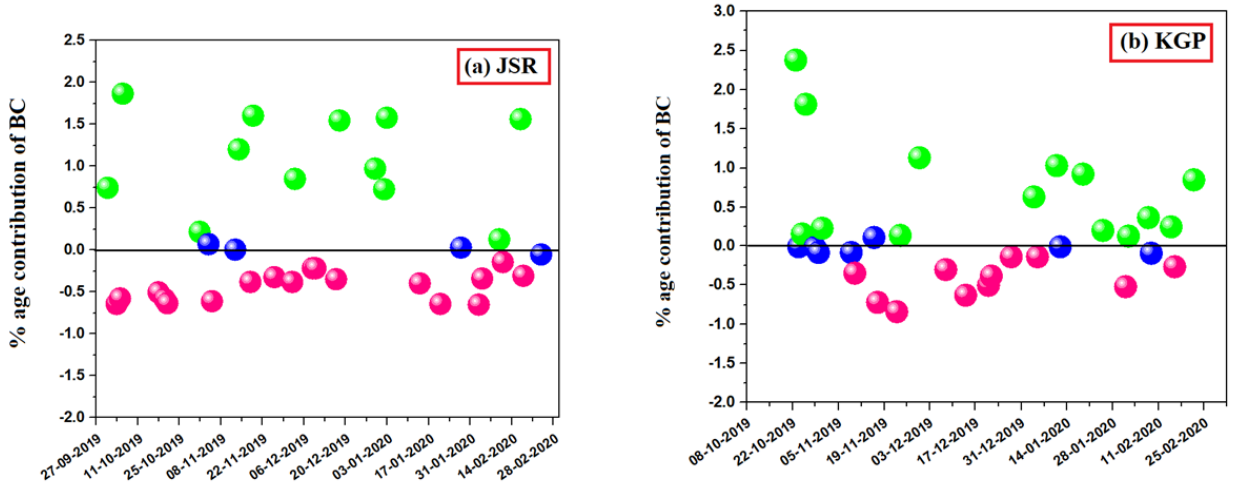
Figure 5. Fractional contribution of BC measured at 370 and 880 nm at ( a ) JSR and ( b ) KGP sites. (Green — wood burning; pink — fossil fuel combustion; blue — mixed fuel burning).